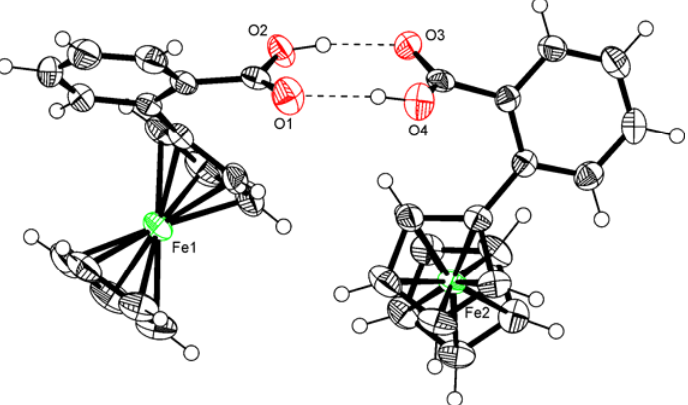
Figure 1. Hydrogen bonding between two independent molecules of 1